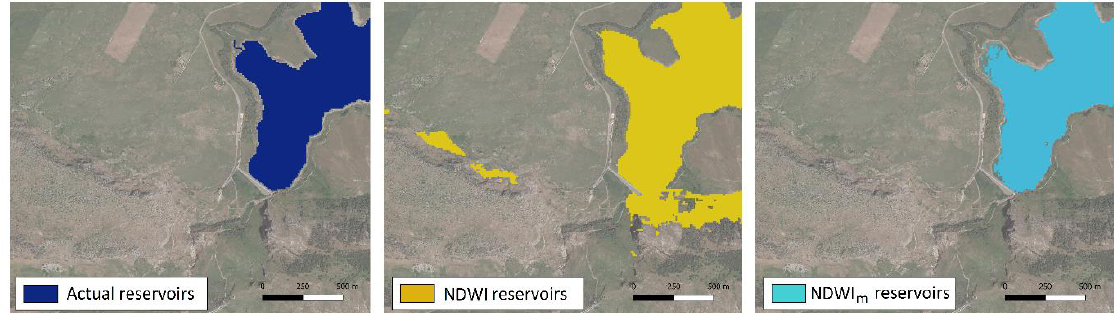
Figure 12. Comparison between the map of actual reservoirs and the maps of reservoirs predicted by the NDWI and NDWI m (17 February 2019).